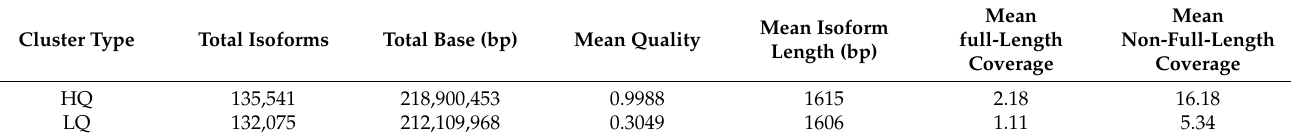
Figure 1. The Read of Insert (ROI) classification and homologous species distribution of full-length transcripts using PacBio Iso-seq. ( a ) ROI classification. ( b ) Homologous species distribution in the NR database. Table 2. Summary of Read of Insert (ROI) clustering information.